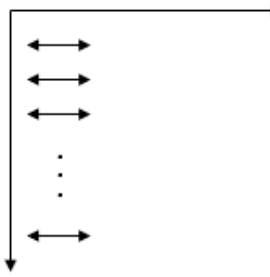
Figure 12. The horizontal traversal.